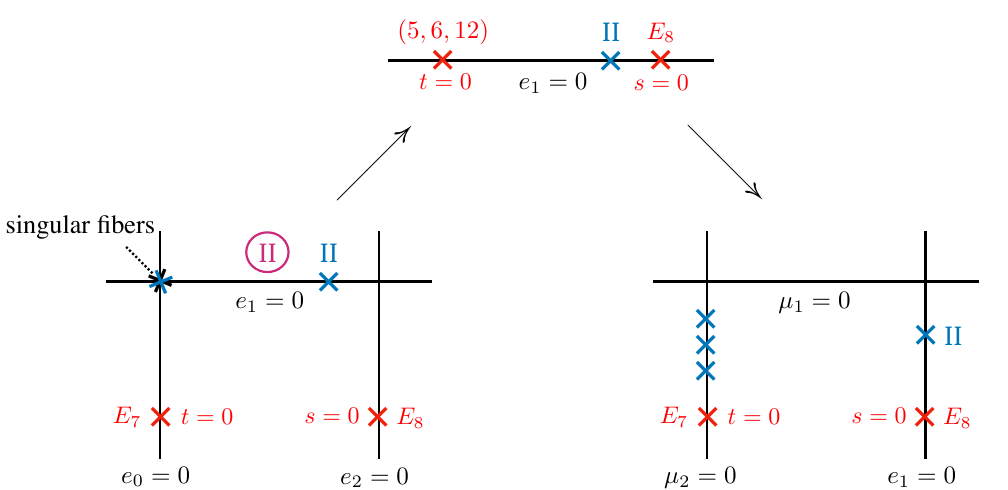
Figure 4 . Blowup of degeneration (4.40) into the non-Kulikov Weierstrass model (4.42)(left), followed by blowdowns and base change (top) and final blowup into a Type II Kulikov Weierstrass model